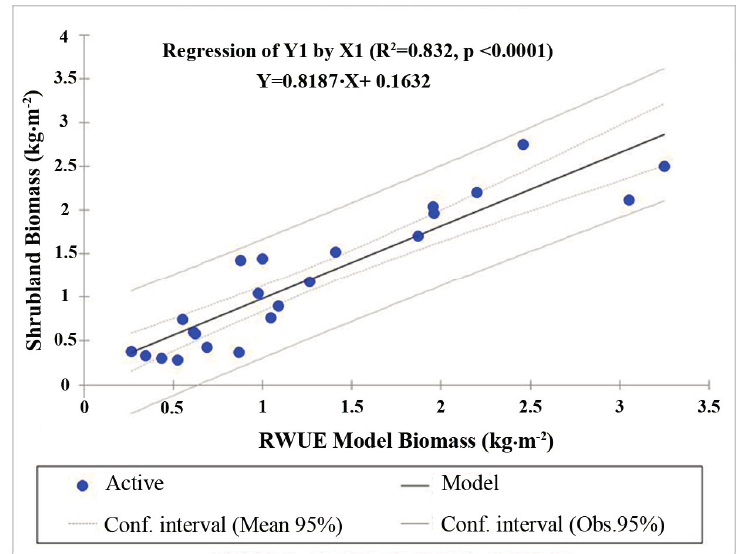
Figure 9. Model (Equation (6)) versus allometric-based estimates of shrubland